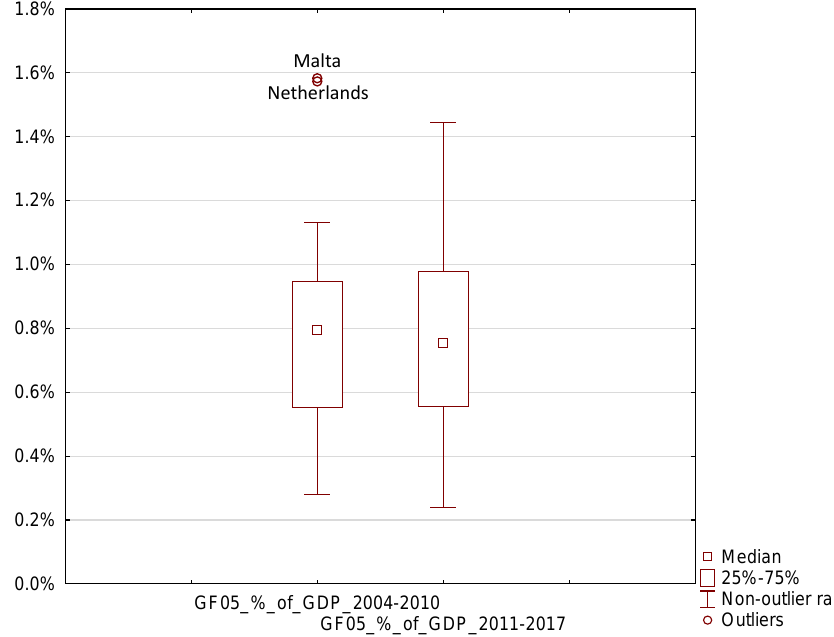
Figure 3. Empirical distribution characteristics of public expenditure on environmental protection (as a percentage of the GDP) in the EU member states in 2004-2010 and 2011-2017. Source: author’s own study carried out using the ‘STATISTICA’